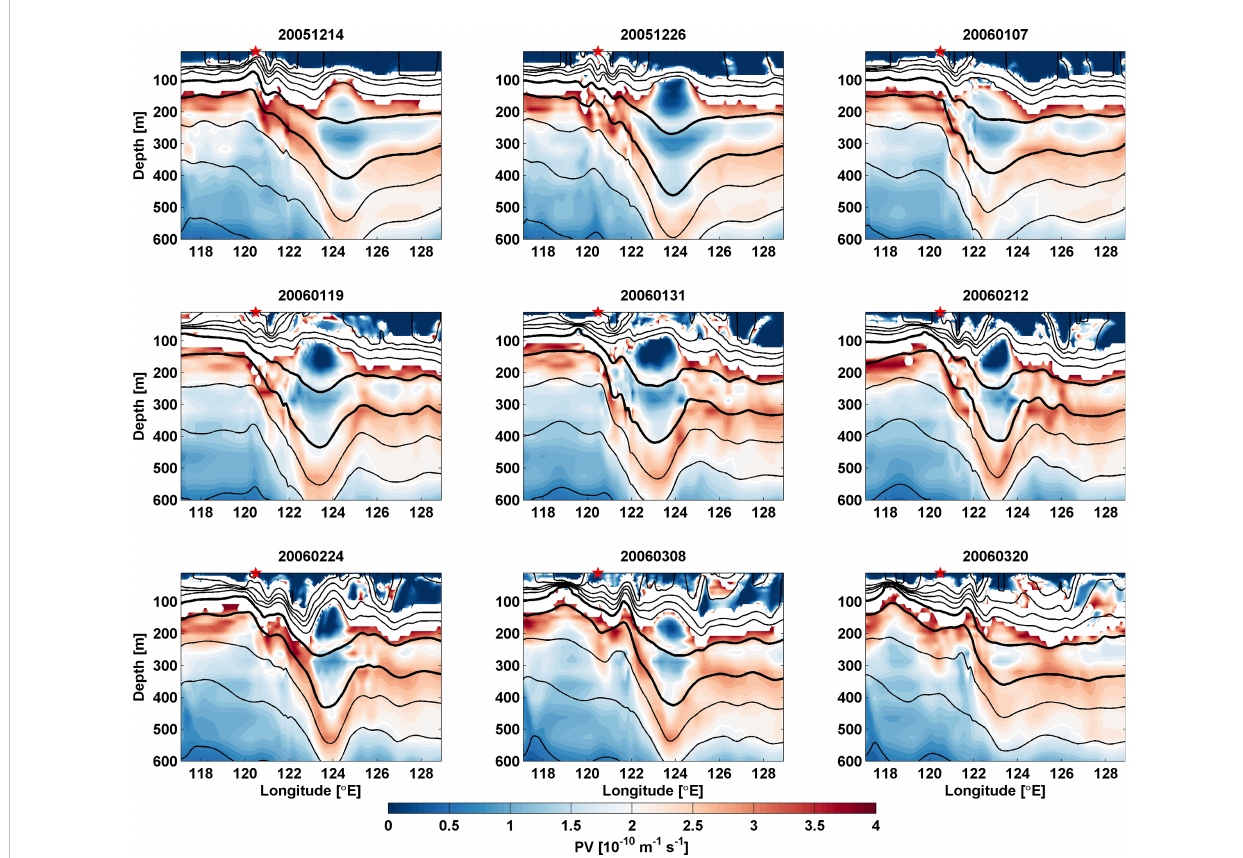
The process of the low PV signal (colors, unit: 10 − 10 m − 1 · s − 1 ) weakening along 21°N east of the Luzon Strait in the 2006 case. The white lines denote the 2 (cid:1) 10 − 10 m − 1 · s − 1 PV contour. The thick black lines denote the 1025 : 0kg · m − 3 and 1025 : 5kg · m − 3 isopycnals.